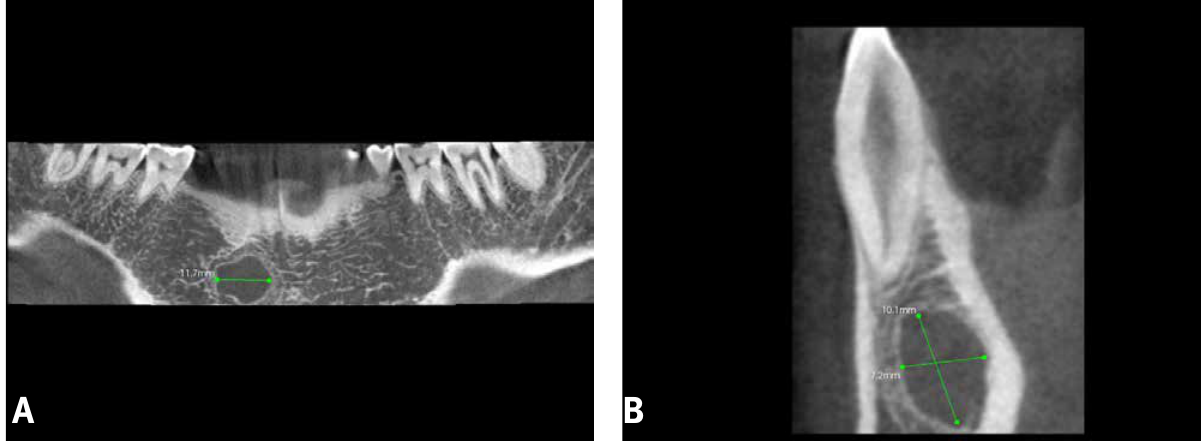
Figure 2a,b: Patient A.R., age 32. CBCT examination of mandible a. Reconstruction of image in horizontal plane. b. Reconstruction of image in vestibular-lingual